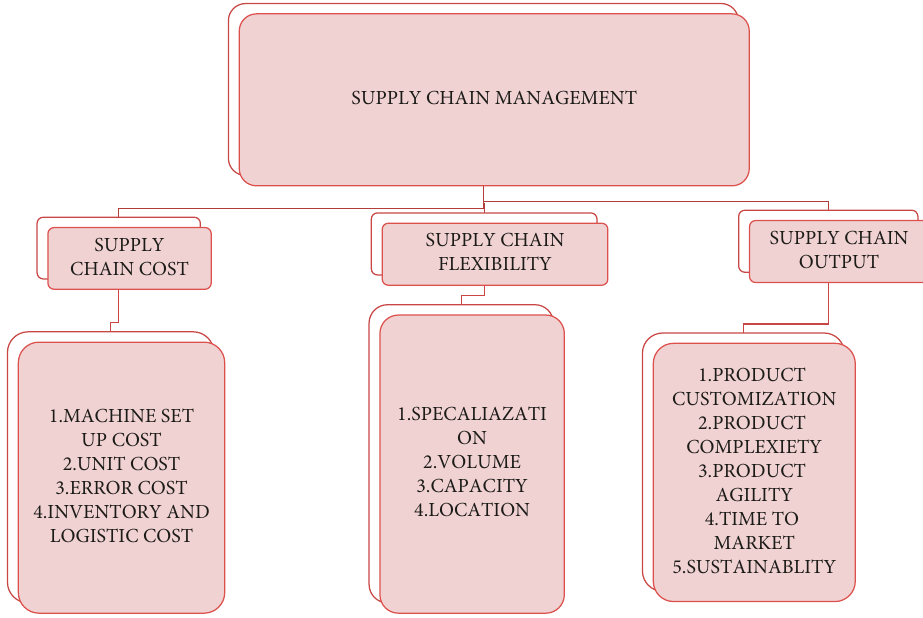
Figure 2: Supply chain management concepts